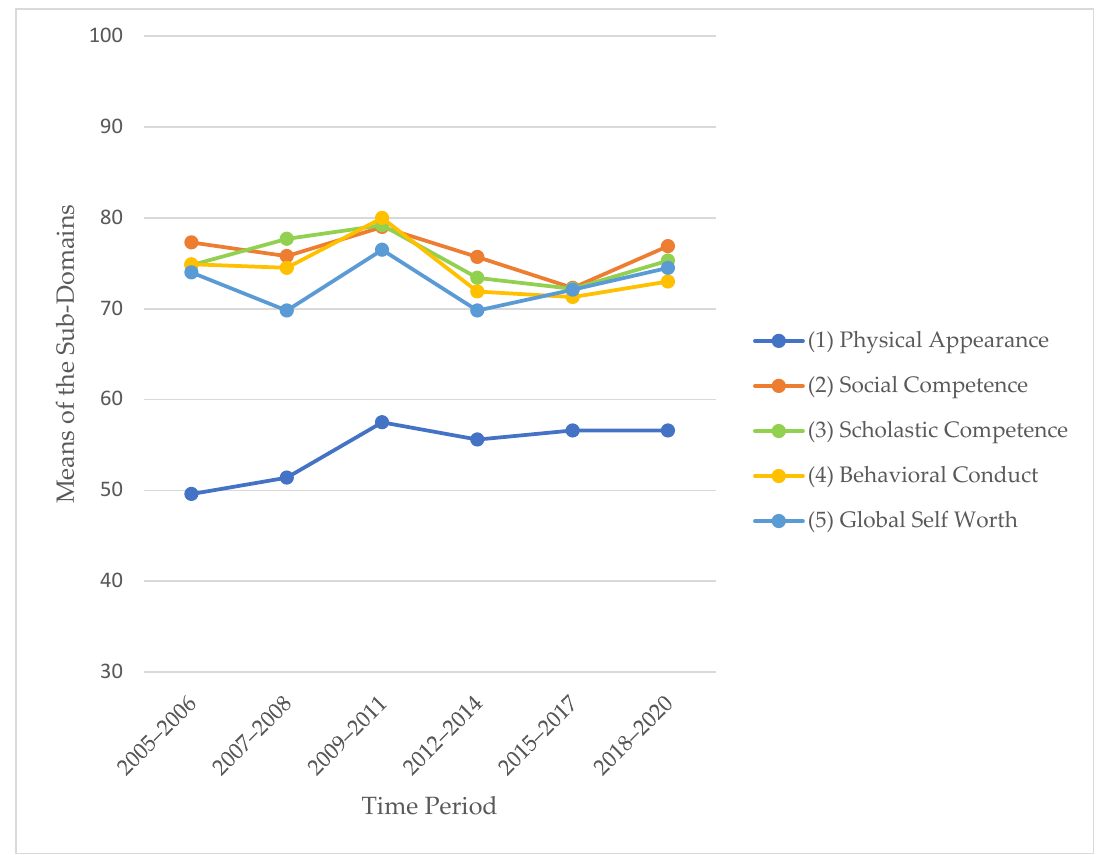
Figure 3. Means of the five sub-domains of self-concept (recoded data scaled 0–100) in the different time periods.